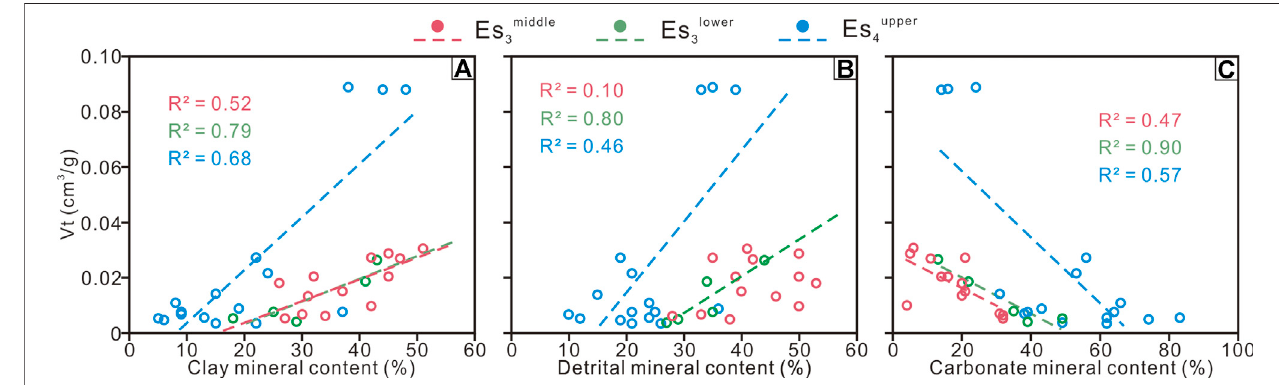
FIGURE 7 | (A) relationships between Vt and clay mineral content; (B) relationships between Vt and detrital mineral content; (C) relationships between Vt and carbonate mineral content.